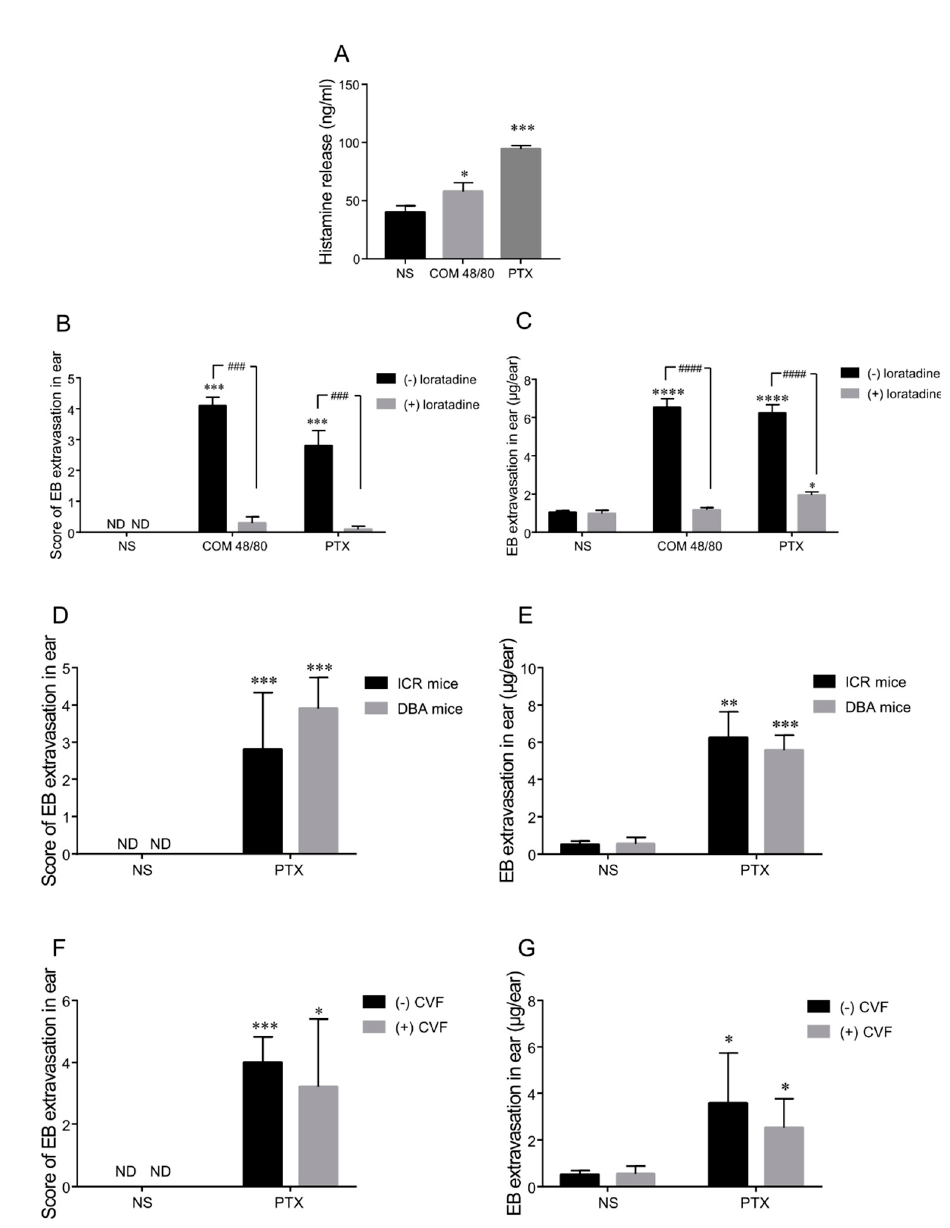
Figure 3. Effects of histamine release and complement activation on PTX injection-induced hypersensitivity reactions. ( A ) Histamine release in Institute of Cancer Research (ICR) mice serum ( n = 5 male mice per group). ( B , C ) Vascular permeability in ICR mice after PTX injection administration with or without pretreatment with loratadine ( n = 10). ( D , E ) PTX injection-induced vascular hyperpermeability in complement factor 5 (C5)-deficient mice (DBA) and ICR mice ( n = 10). ( F , G ) With or without complement depletion pretreated by a Cobra venom factor ( n = 10). ND indicted ear bluing score = 0. * p < 0.05, ** p < 0.01, *** p < 0.001, and **** p < 0.0001, comparisons were made in the treatment group vs. the NS group; ### p < 0.001, and #### p < 0.0001, with vs. without loratadine.